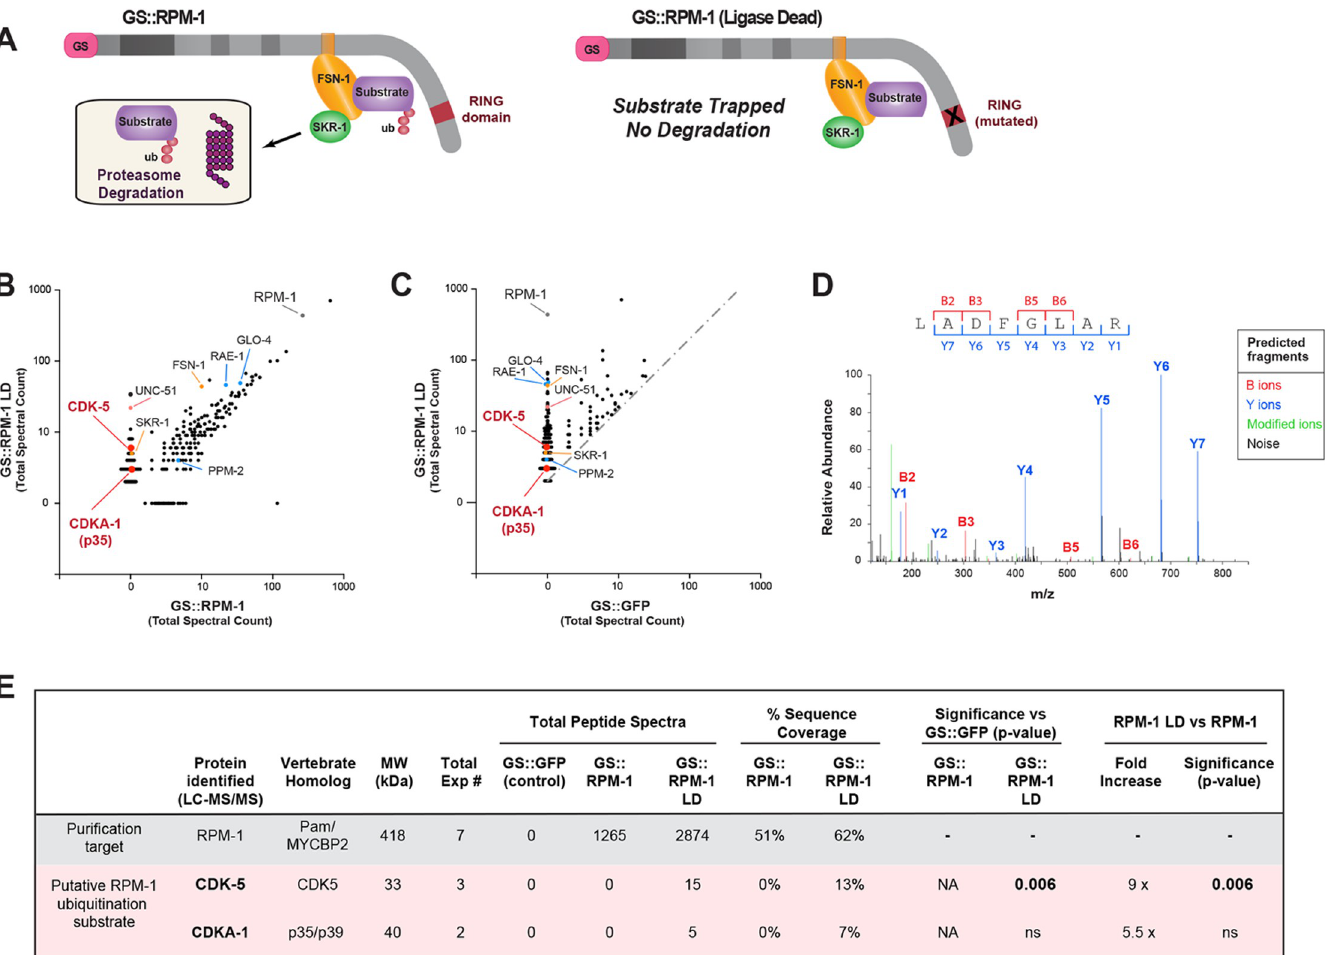
Fig 1. Proteomics from C . elegans identifies CDK-5 as a putative substrate for the RPM-1 ubiquitin ligase. A) Schematic of RPM-1 ubiquitin ligase complex and GS tagged constructs used for affinity purification proteomics. GS::RPM-1 LD substrate ‘trap’ does not ubiquitinate substrates which can still bind to the FSN-1 substrate recognition module. As a result, RPM-1/FSN-1 ubiquitination substrates are enriched, but not ubiquitinated and not degraded by the proteasome. Note transgenic GS:: RPM-1 LD is generated on an rpm-1 null background to facilitate substrate enrichment and interactions with the endogenous, untagged ubiquitin ligase components FSN-1 and SKR-1(SKP1). B ) Scatter plot showing a single affinity purification proteomic experiment comparing proteins identified in GS::RPM-1 LD substrate ‘trap’ versus GS::RPM-1. Highlighted in red are CDK-5 and CDKA-1(p35) which are exclusive to GS::RPM-1 LD. Identified in both samples are known RPM-1 binding proteins (blue), components of the RPM-1 ubiquitin ligase complex (orange) and a previously validated substrate (UNC-51, orange). C ) Scatter plot showing the same single proteomic experiment comparing GS::RPM-1 LD versus GS::GFP (negative control). Gray dashed line delineates two-fold enrichment. D ) Example LC-MS/MS spectrum for one CDK-5 peptide identified in GS::RPM-1 LD sample. Shown are B ions formed from the amino terminus and Y ions formed from the carboxyl terminus. m/z represents mass to charge ratio with peptide size increasing to the right. E ) Summary of results from 7 independent proteomic experiments with RPM-1. Significance determined using Student’s t -test with p-values annotated. ns , not significant (p > 0.05); NA, not applicable.